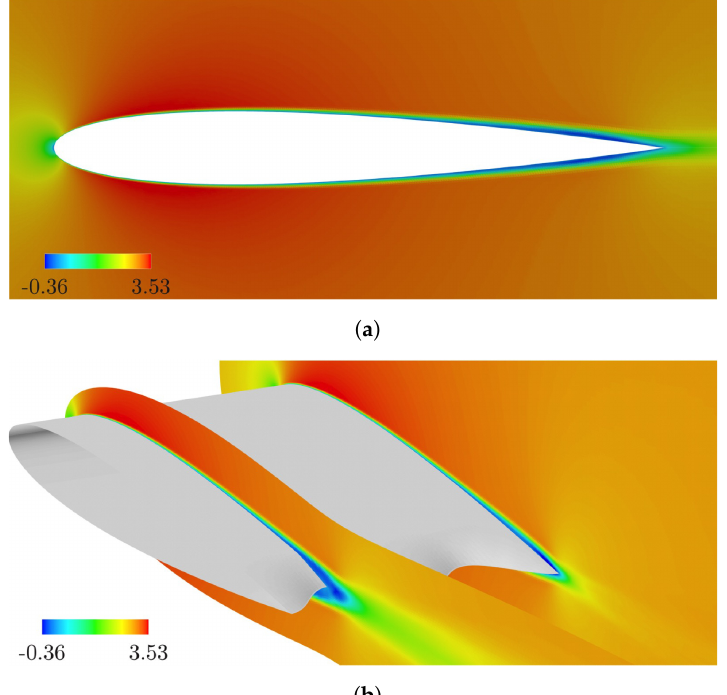
Figure 6. Profile of mean velocity distribution around straight and serrated airfoils: ( a ) NACA0012 airfoil; and ( b ) serrated